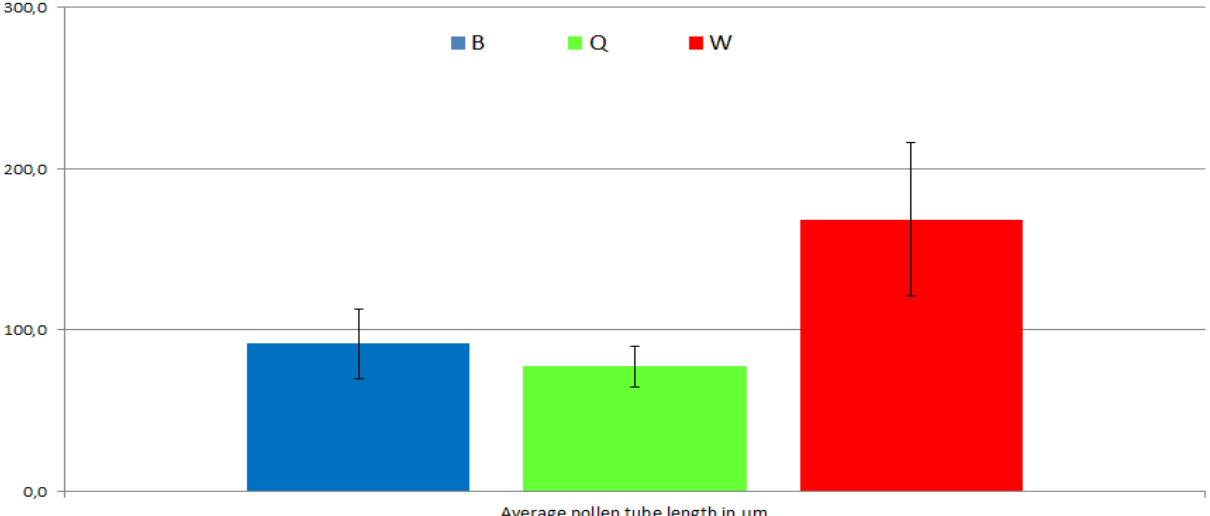
Figure 4. Wt pollen tube length after 6 hours of incubation in the three different growth media, B, Q and W.